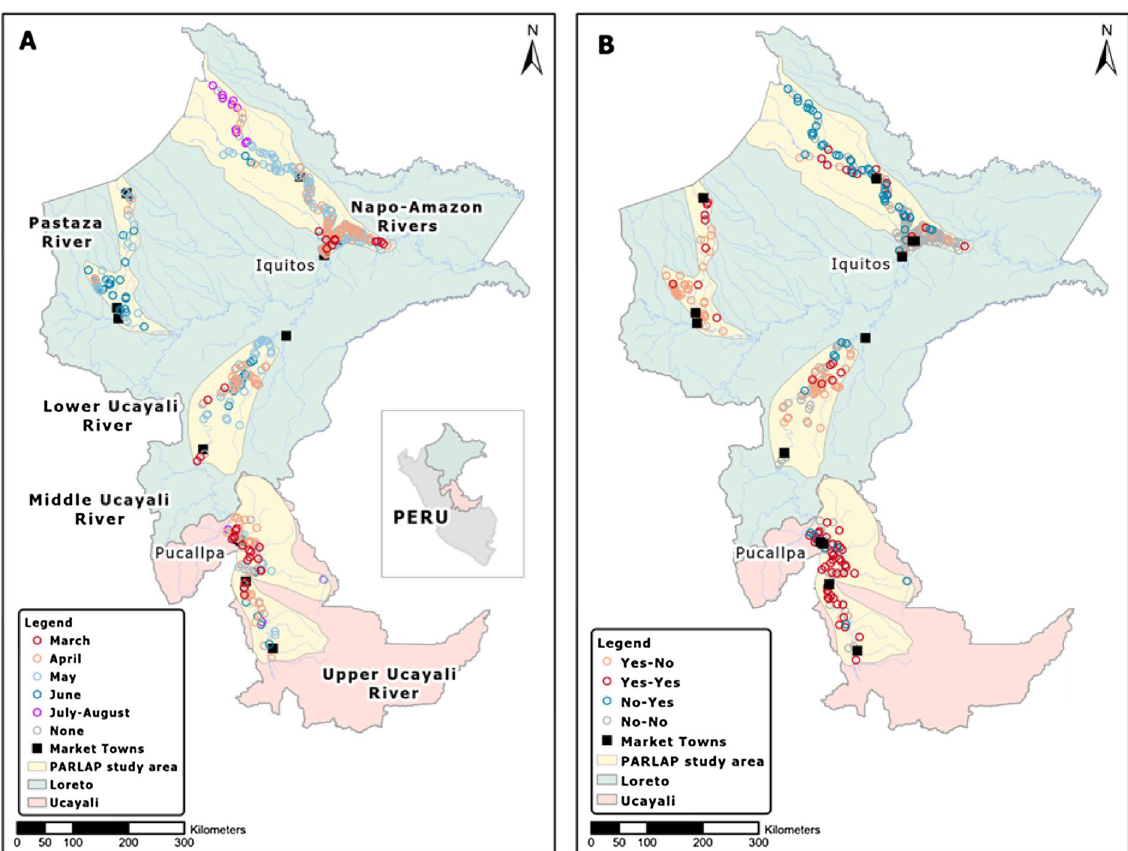
Figure 1. COVID-19 spread and evolution across communities. First COVID-19 case in 2020 ( A ) and COVID- 19 evolution between the baseline survey (in July 2020) and the follow-up survey (in August 2020) (for example, Yes–No means any case at the baseline and no case at the follow-up) ( B ). In A, June includes two communities which experienced first case in July; July–August means first case which occurred between the baseline and follow-up